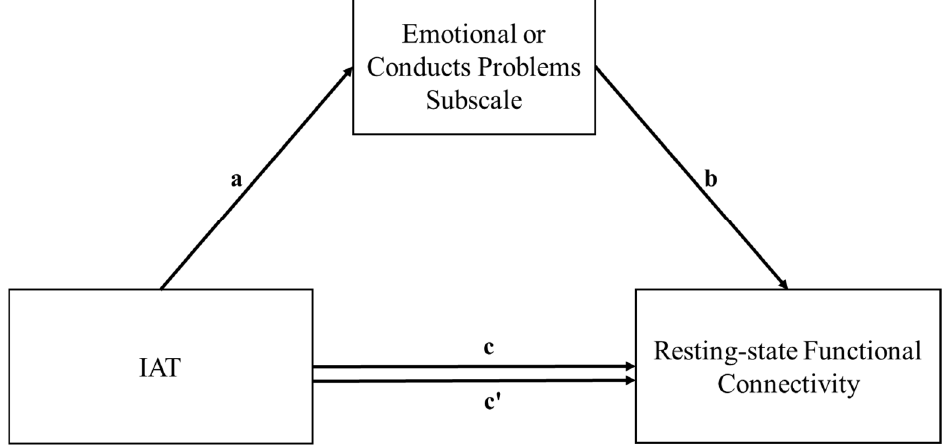
Figure 2. Conceptual diagram of mediation analysis between internet addiction, functional con- nectivity, emotional symptoms, and conduct problems subscales of SDQ. Resting-state functional connectivity includes: LPFC(L)-MPFC, LPFC(L)-LP(R), and LPFC(L)-aIns(L). a: independent variable direct effect on mediator; b: mediator direct effect on dependent variable; c: direct effect of inde- pendent on dependent variable; c’: indirect effect of independent on dependent variable, ab: indirect effect of independent on dependent variable through mediator. LPFC (L), Left lateral prefrontal cortex; MPFC, Medial prefrontal cortex; LP(R), Right lateral parietal; aIns(L), Left anterior insula. Table 3. Mediation analysis of SDQ subscales toward correlation of IAT scores and functional connectivity.